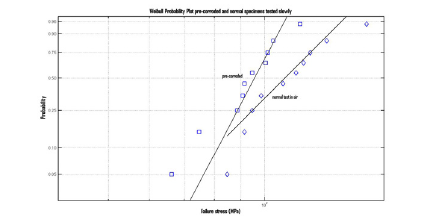
Figure 9: Weibull plot of results of slow tests in air on normal and pre-corroded specimens.